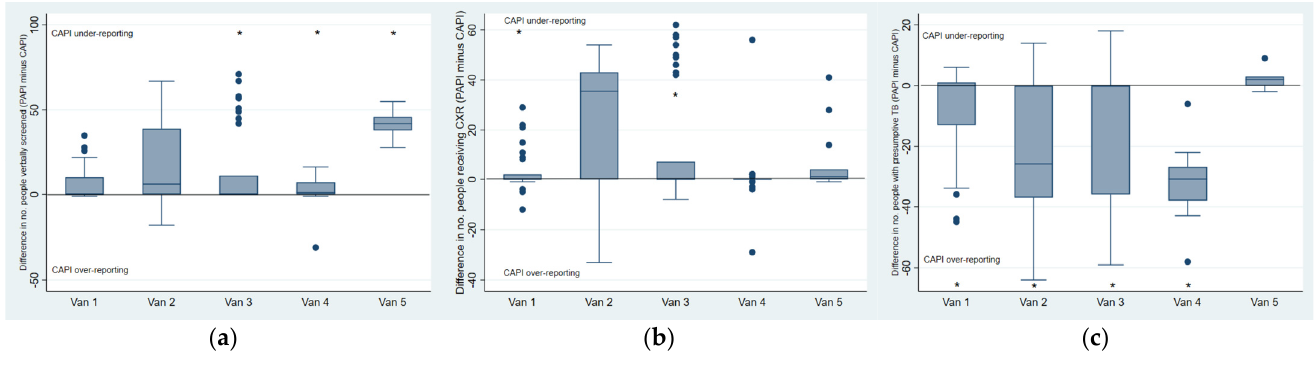
Figure 4. Consistency of CAPI and PAPI indicators Per van (PAPI-CAPI). ( a ) People verbally screened; ( b ) people receiving chest X-ray; ( c ) people identified with presumptive TB. * Significant difference ( p < 0.05) in mean values reported between PAPI and CAPI.